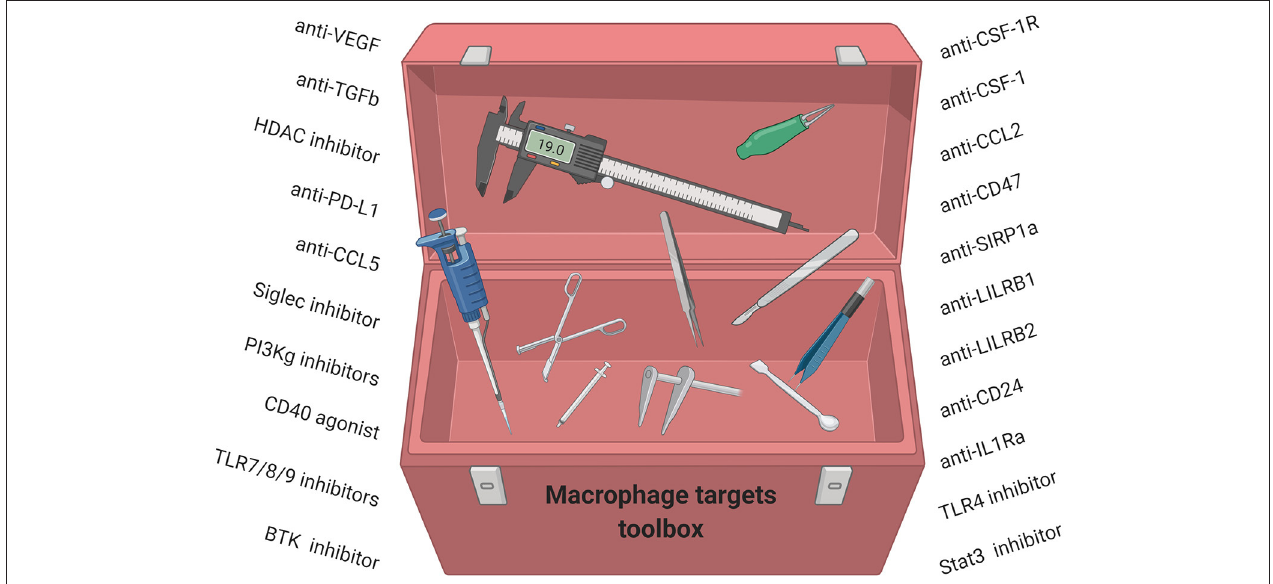
FIGURE 4 | Macrophage-targeting strategies for anti-cancer therapy have started to fill our toolbox. We now need to understand how these compounds work, which subsets of TAMs they modulate, and which breast cancer patients will